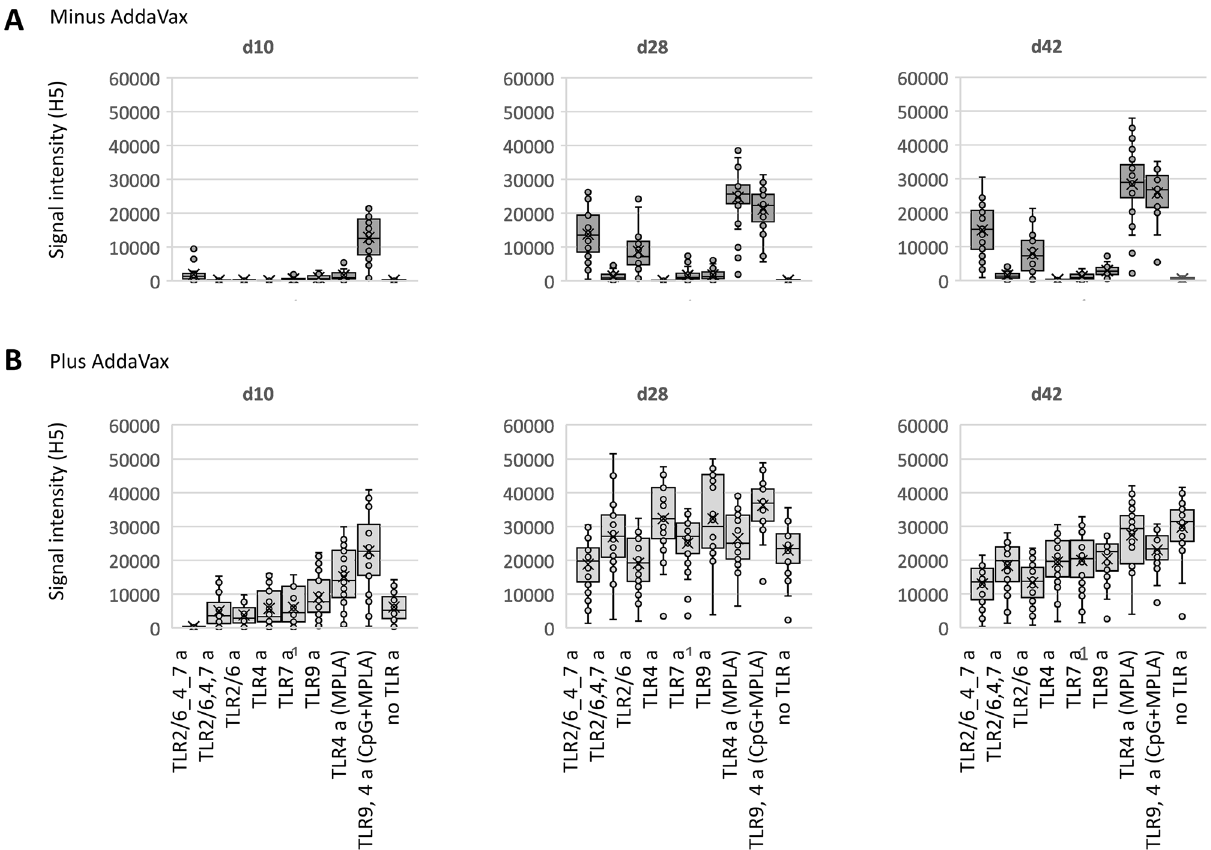
Figure 4. Dynamics of IgG profiles in response to trimerized influenza virus VN04 H5 vaccine formulated with different TLR agonists. Box plots of H5 drift variants; each spot corresponds a different H5 variant on the microarray (geometric mean of 4 mice). Different TLR agonists, listed at the bottom, were administered ( A ) without or ( B ) with squalene oil-in-water emulsion (AddaVax). Abbreviations, as Fig.